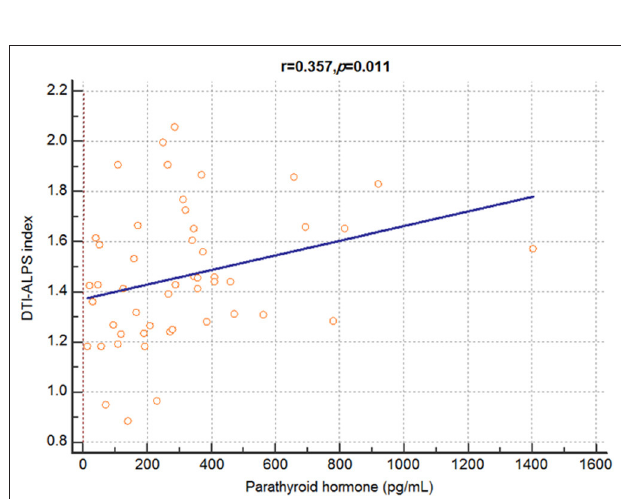
FIGURE 2 | Correlation analysis between DTI-ALPS index and serum parathyroid hormone levels in patients with dialysis. A significant positive correlation is observed between the DTI-ALPS index and serum parathyroid hormone levels in patients with end-stage renal disease. DTI-ALPS, diffusion tensor image analysis along with the perivascular